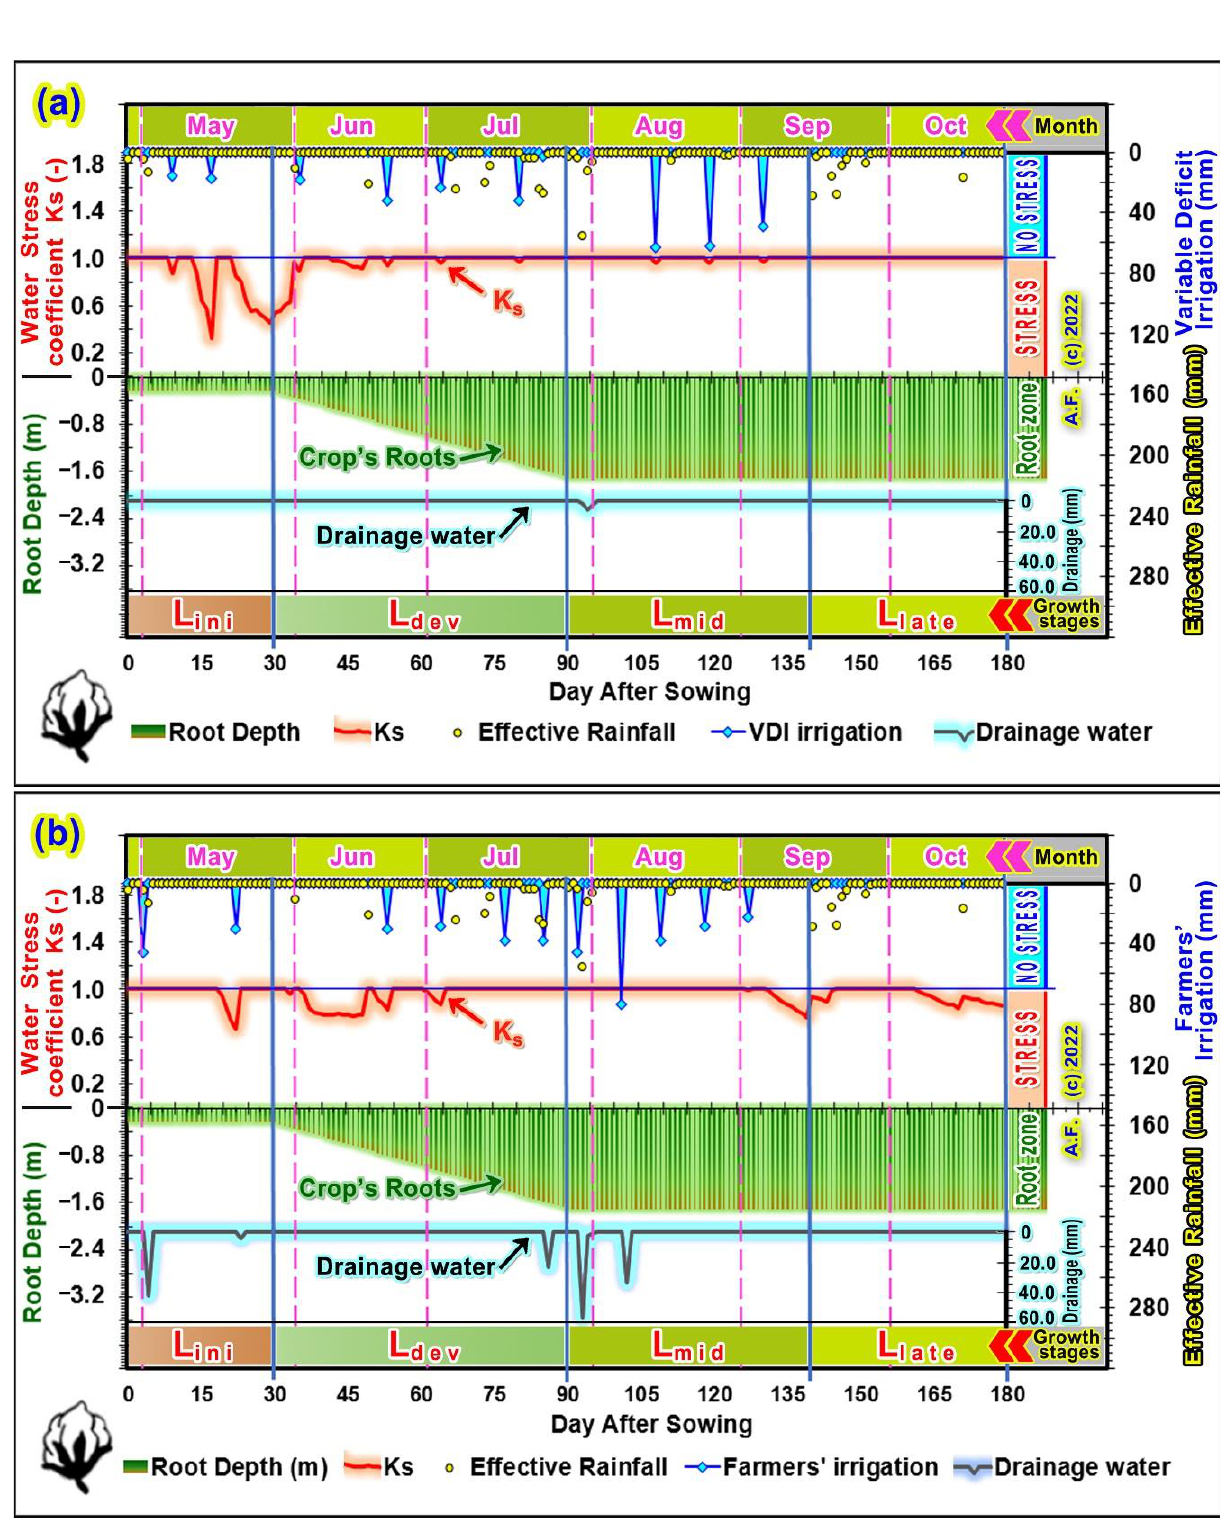
Figure 6. Cotton’s roots growth results of the daily soil – water – crop – atmosphere model, the Ks wa- ter stress results, and the depletion model results for the four cotton growth stages of ( a ) IR1:VDI-2 irrigation treatment and ( b ) treatment for IR2:FI-2 f armers’ common irrigation practice s.